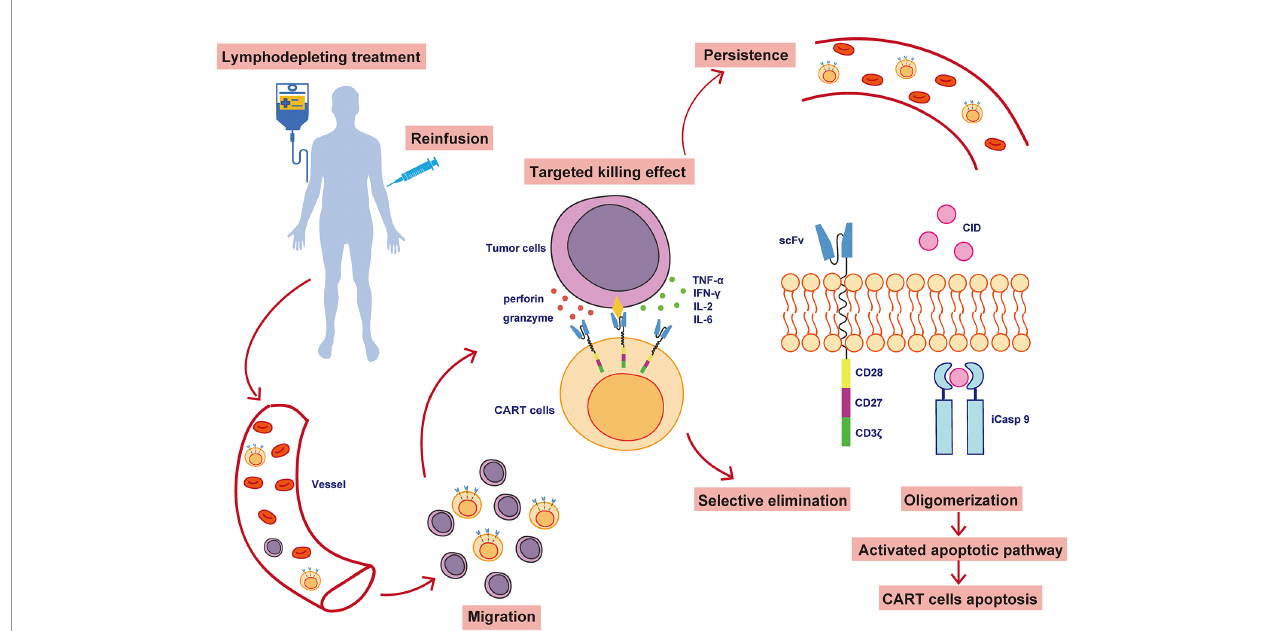
FIGURE 1 | The structure and in vivo activity of 4SCAR19 T cells. CAR-T cells, chimeric antigen receptor T cells; scFv, single-chain variable fragment; iCasp 9, inducible caspase 9; CID, chemical inducer of